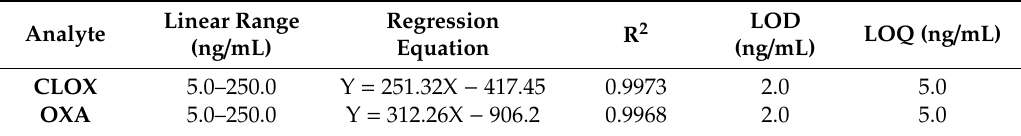
Table 1. Method characteristics of PPy-PA6-NFsM when combined with CE-DAD. LOD: limit of detection; LOQ: limit of quantification.